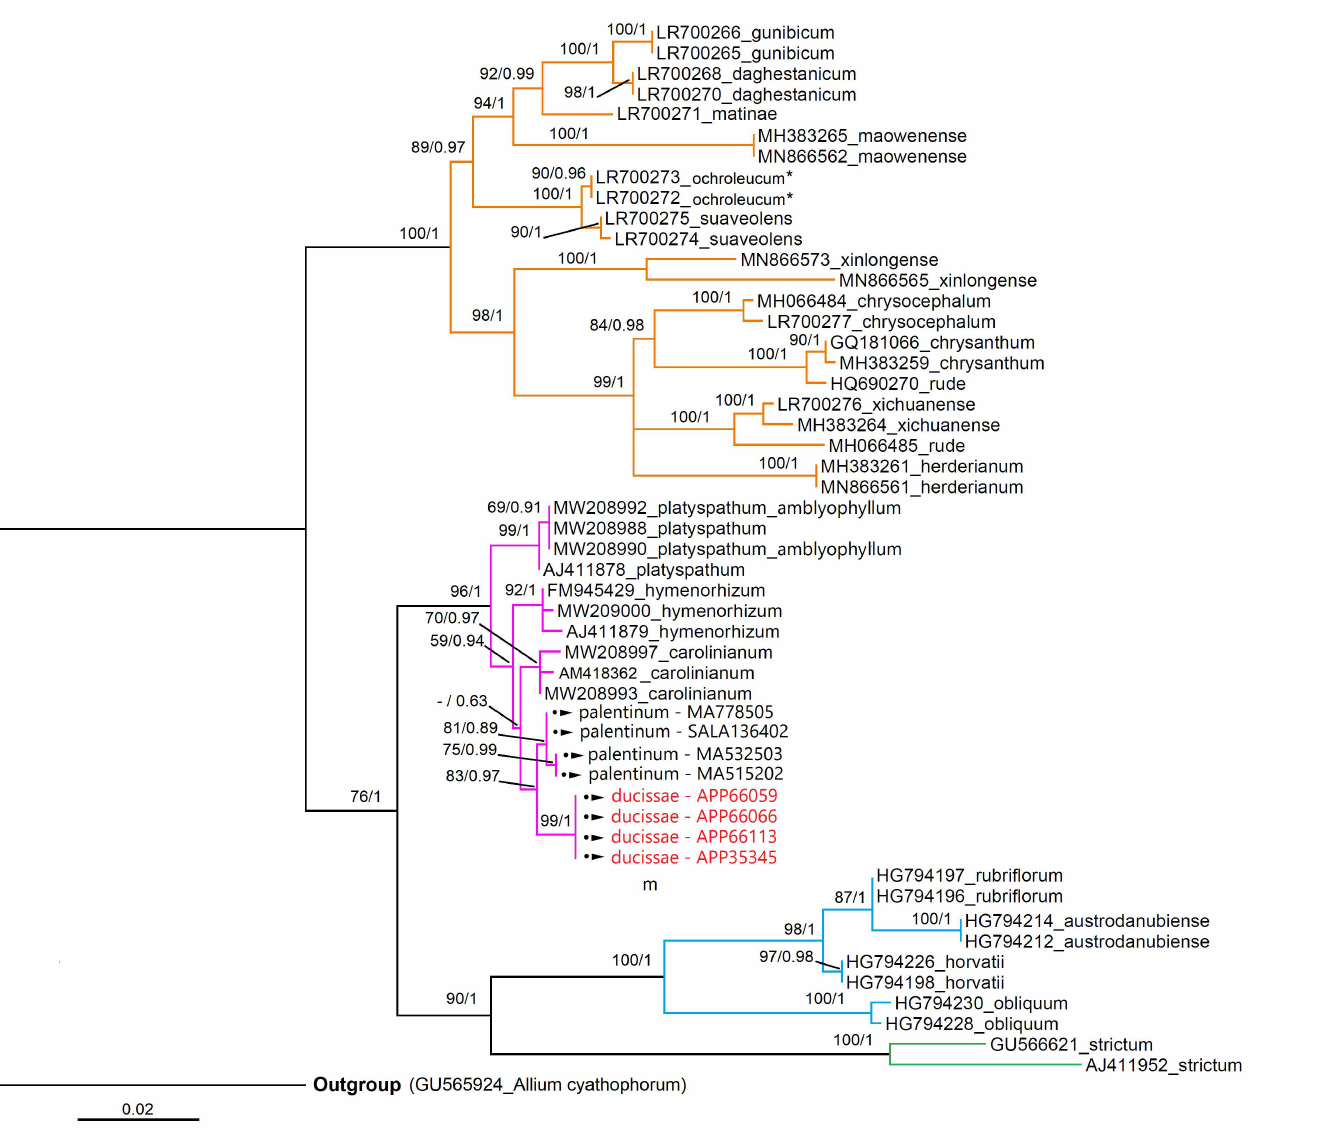
Figure 10. Maximum likelihood (ML) phylogram of newly generated and previously published ITS sequences of Allium (GenBank code + specific epithet). The newly generated sequences have symbol ( • (cid:73) ) and in red the samples of A. ducissae sp. nov. Accessions belonging to A. sect. Daghestanica are shown with orange branches, sect. Falcatifolia in pink, sect. Oreiprason and Reticulobulbosa in blue and green, respectively. ML bootstrap values followed by Bayesian posterior probabilities are shown above the branches (BS/PP values > 50%). *, species reported in Freisen et al. (2020) as A. ericetorum Thore. For information of the samples, see Supplementary Table S1 and for ITS matrix see Supplementary File